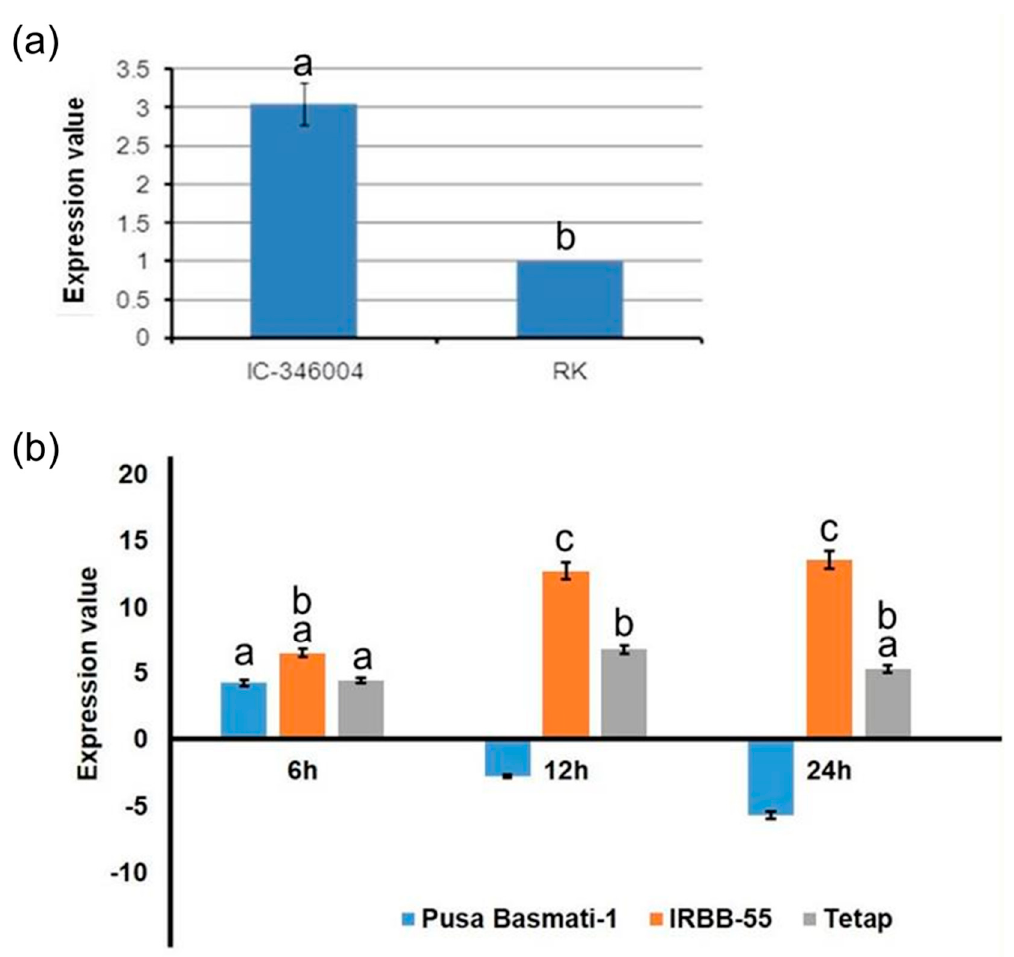
Figure 11. ( a ) Transcriptional response of OsCBP60g-4 in uninfected leaves of IC-346004 and Rajendra Kasturi rice seedlings grown under controlled conditions. Relative transcript abundance (Expression value) of OsCBP60g-4 is expressed as fold-change in IC-346004 relative to Rajendra Kasturi. Results are representative of three independent experiments. Error bars represent standard error (SE) of mean for three replicates. Different lower-case letters indicate statistically significant differences ( p < 0.05) by one-way ANOVA-protected LSD test. ( b ) Transcriptional response of OsCBP60g-4 in leaves of rice genotypes Pusa Basmati-1, IRBB-55 and Tetap infected with X. oryzae pv. oryzae at 6, 12 and 24 h post infection. Relative transcript abundance (Expression value) is expressed as fold-change relative to the mock treatment. Results are representative of three independent experiments. Error bars represent standard error (SE) of mean for three replicates. Superscripts with the same letter are not significantly different ( p < 0.05) by one-way ANOVA-protected LSD test.